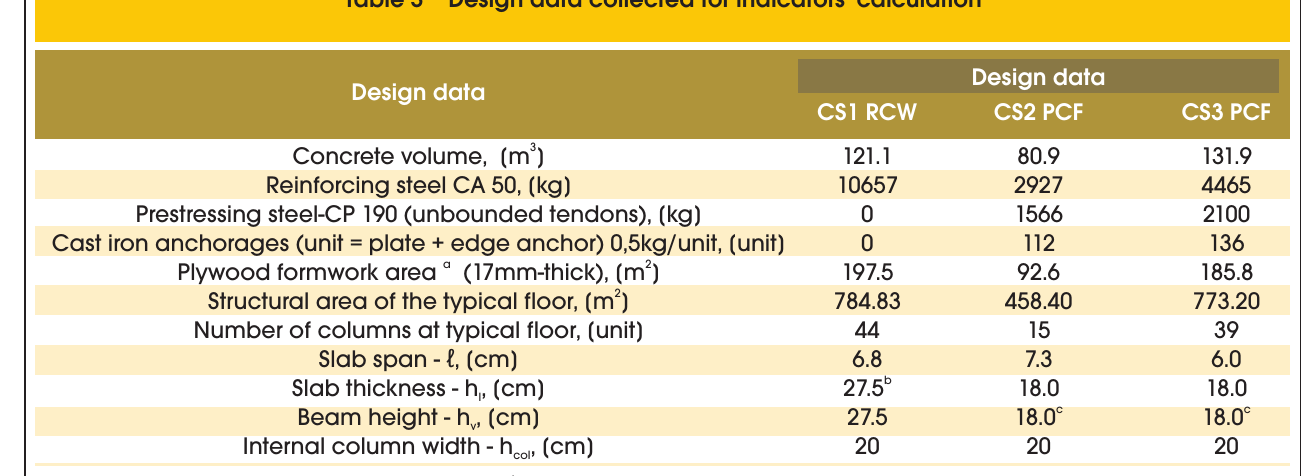
Table 3 – Design data collected for indicators'